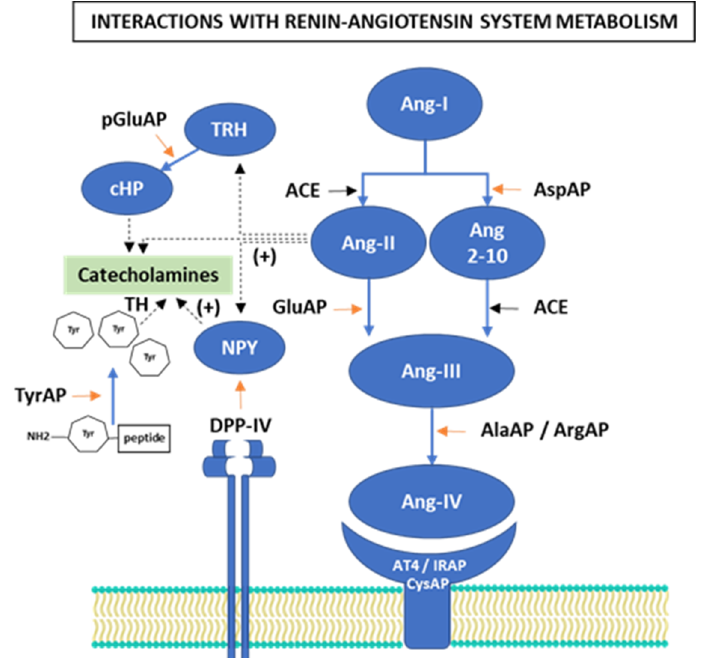
Figure 1. Downstream summary diagram of the classical and non-classical pathway of the renin-angiotensin system (RAS) and its interaction with stimulatory-hydrolyzing pathways of neuropeptide Y (NPY) and catecholamines. ACE: angiotensin converting enzyme AlaAP: alanyl-aminopeptidase; Ang 2-10: Angiotensin 2-10; Ang-I: angiotensin I; Ang-II: angiotensin II; Ang-III: angiotensin III; Ang-IV: angiotensin IV; ArgAP: arginyl-aminopeptidase; AspAP: aspartyl-aminopeptidase; cHP: histidyl-proline diketopiperazine; DPP-IV: dipeptidyl peptidase IV; GluAP: glutamyl-aminopeptidase; AT4/IRAP/CysAP: angiotensin IV receptor/insulin-regulated aminopeptidase/cystinyl-aminopeptidase; NH2: amino terminal; NPY: neuropeptide Y; pGluAP: pyroglutamyl-aminopeptidase; TH: tyrosine hydroxylase; TRH: Thyrotropin-releasing hormone; Tyr: tyrosine; TyrAP: tyrosyl-aminopeptidase.